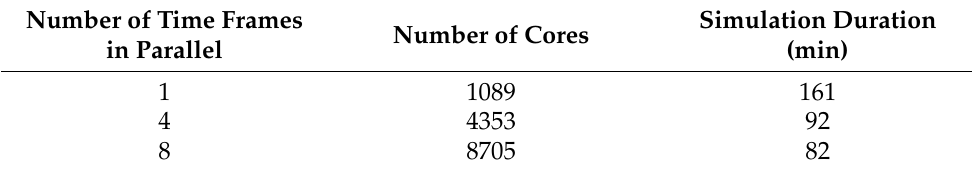
Table 2. Duration of simulations for the flow on the large